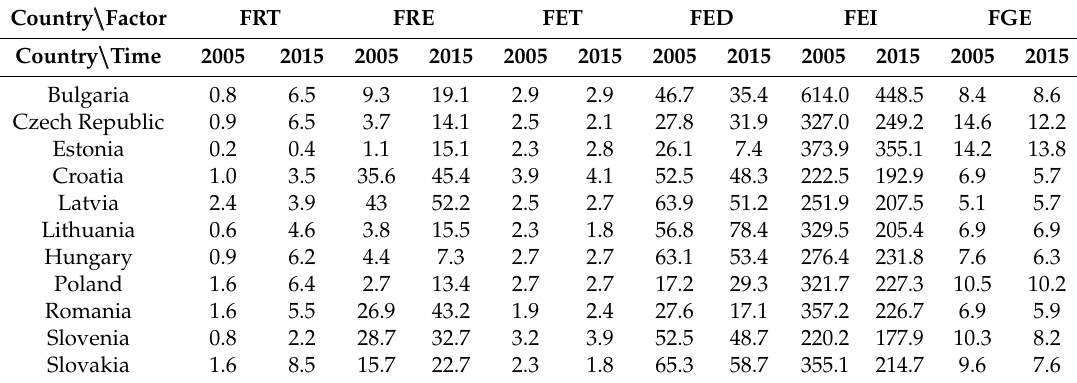
Table 4. Factors for renewable energy development